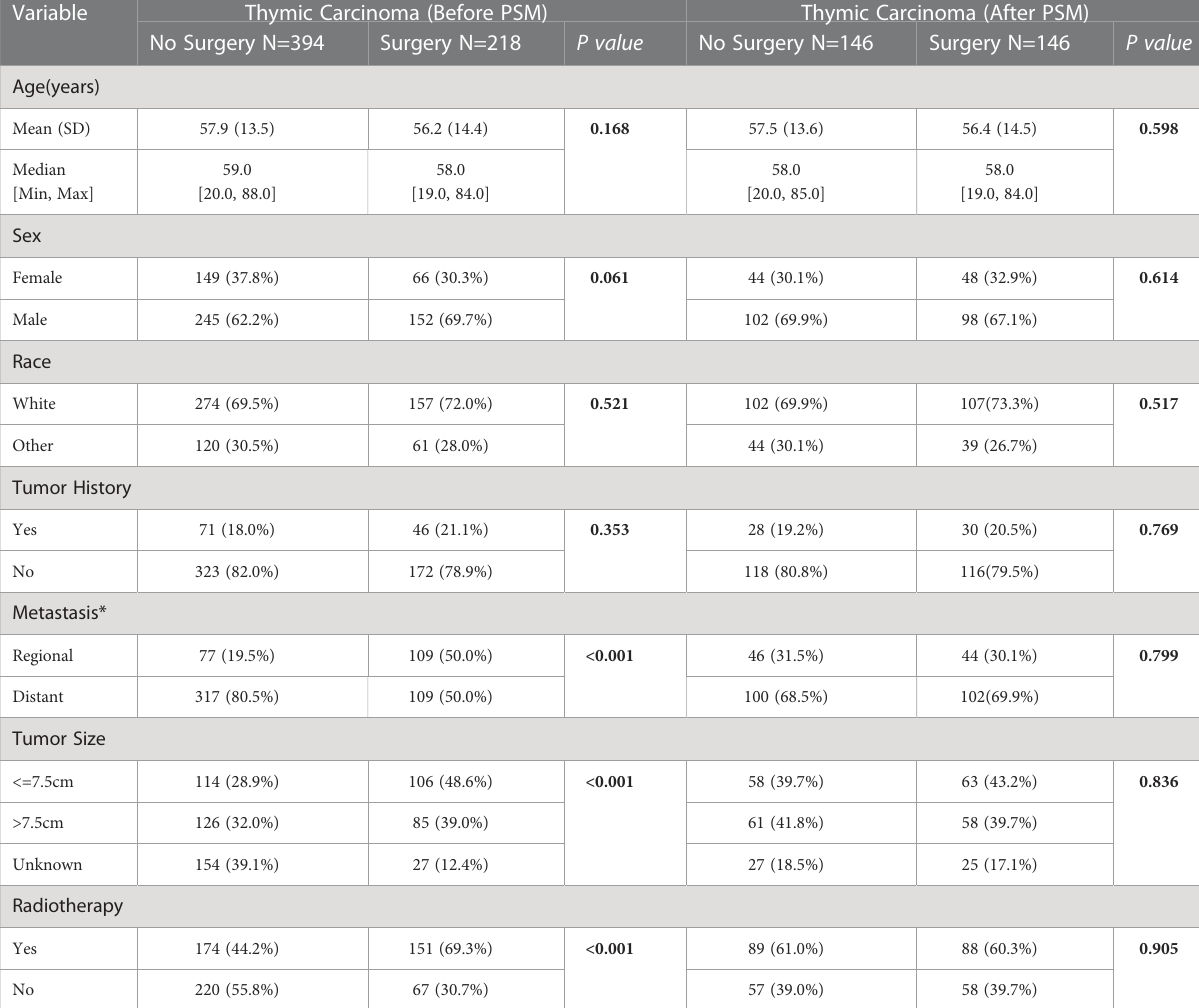
TABLE 3 The information on before and after PSM in patients with thymic